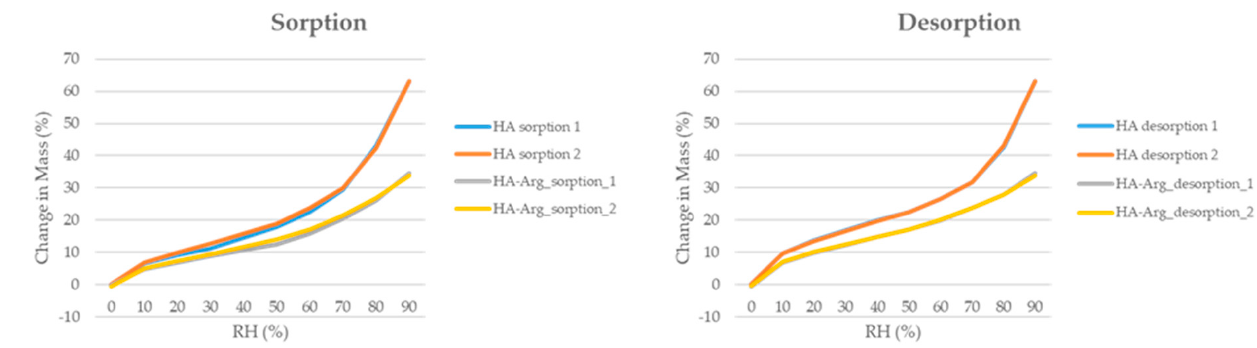
Figure 7. DVS isotherms of two cycles of moisture sorption and desorption of HA and HA-Arg.